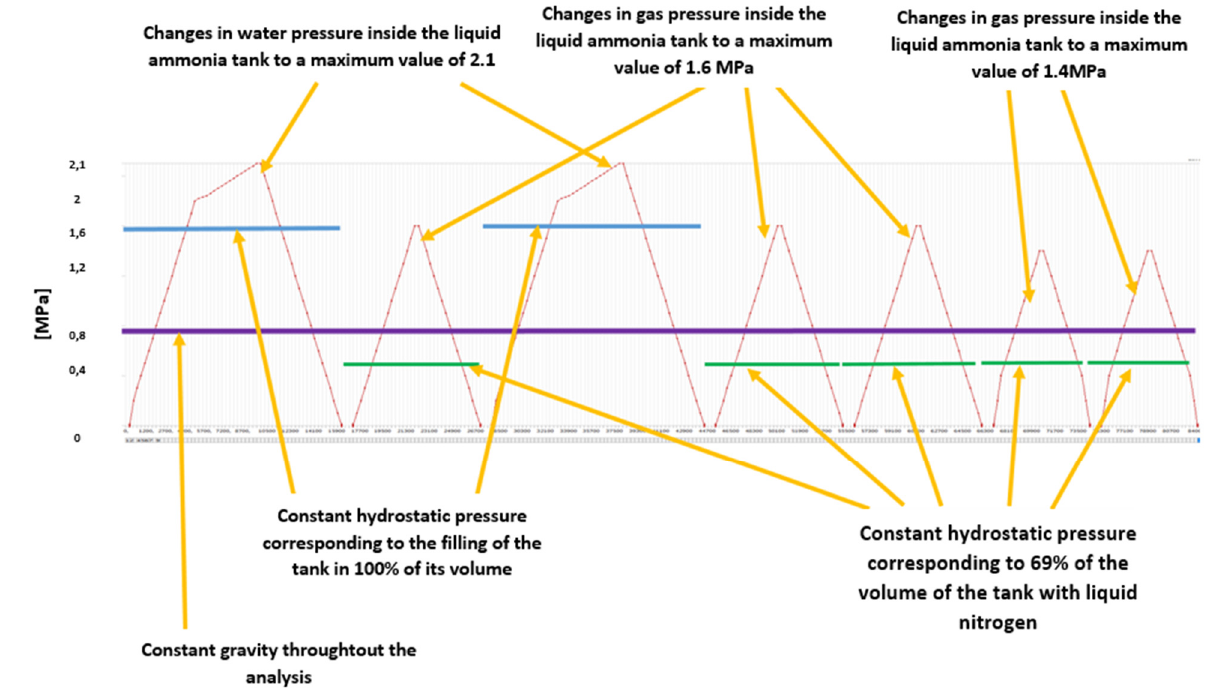
Figure 13. The load scheme adopted to carry out nonlinear numerical calculations taking into account the overloading of tanks with the use of a water tests and then standard operational conditions. Selected results of numerical calculations for contour’s specific forms of von Mises stresses are shown in the figures below (Figure 14).